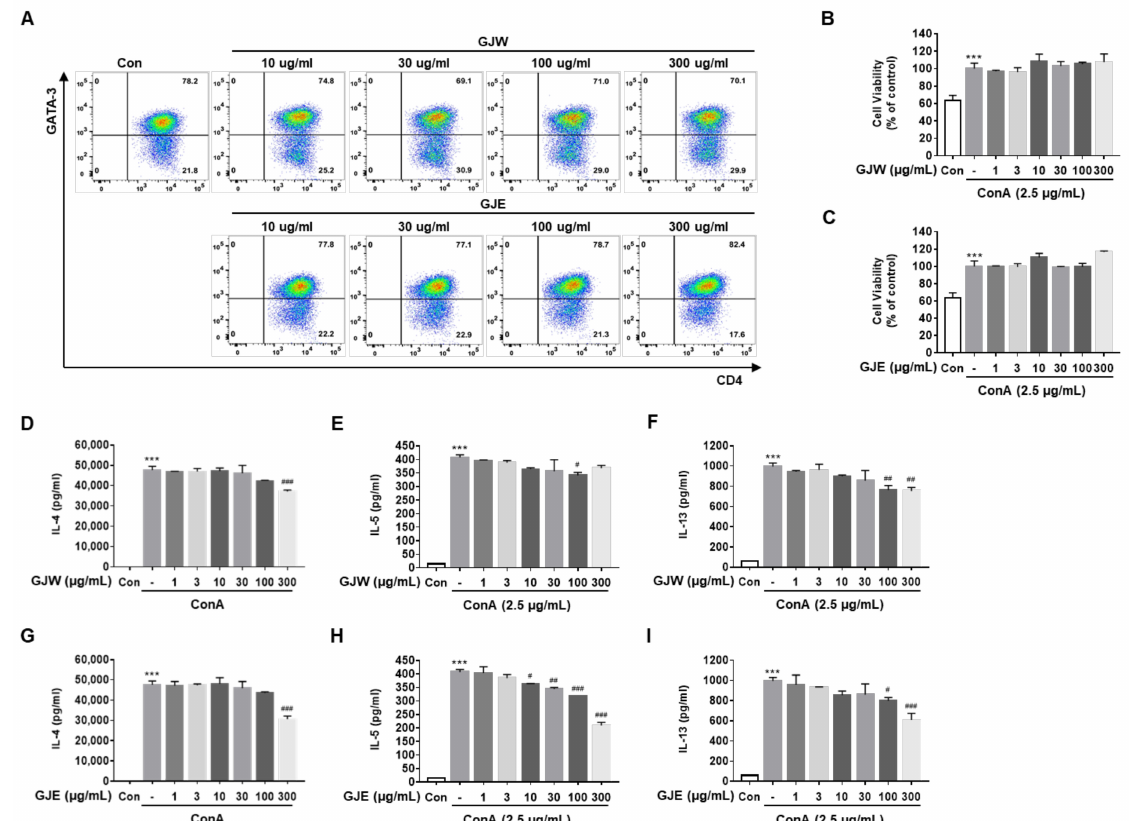
Figure 4. Effects of Gardenia jasminoides water (GJW) and 70% ethanol (GJE) extracts on the secretion of cytokines in differentiated Th2 cells. Naïve CD4+ T cells were differentiated into Th2 cells over 6 days. ( A ) The frequency of differentiated Th2 cells (CD3 + CD4 + GATA3 + cells) was examined using flow cytometry after treatment with GJW or GJE. ( B , C ) The viability of the differentiated Th2 cells was analyzed using EZ-Cytox solutions at the indicated concentrations of GJW or GJE. ( D – I ) The cytokine secretion levels in Th2 cells were assessed using LEGENDplex and flow cytometric analysis of the cell culture media. The data are presented as means ± standard deviations ( n = 3). *** p < 0.001 vs. control; # p < 0.05, ## p < 0.01, and ### p < 0.001 vs. ConA. Con, control; ConA, concanavalin A; IL,